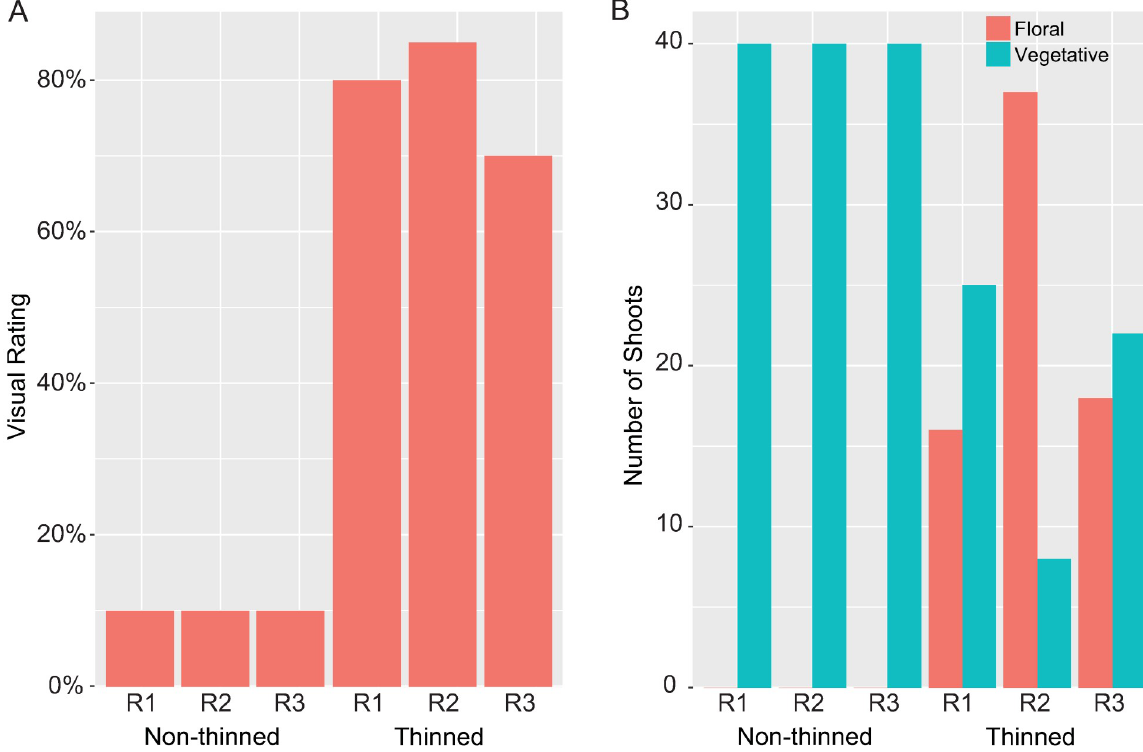
Fig 1. Effect of flower removal on subsequent-year flowering. At full bloom, trees were thinned of flowers or were left non-thinned, and the fraction of flower-bearing shoots, relative to total shoots arising from spur structures, was evaluated the following spring. (A) Visual estimation of floral density. The rating scale extends from 0% (no obvious flowers) to 100% (abundant flowers). Visual density was estimated by two, independent, trained observers (correlation p value < 0.05). (B) Quantification based on sampling a minimum of 40 spur shoots designated for evaluation prior to flower removal. Graphs show the results from three biological replicates